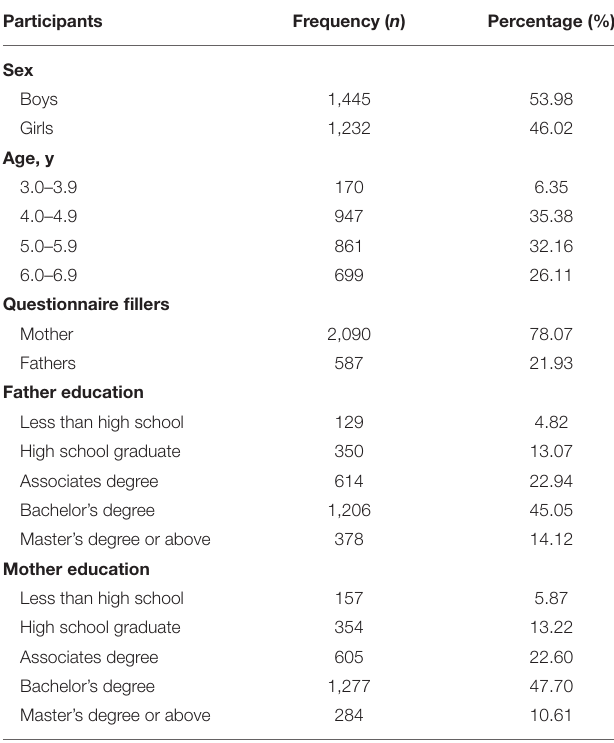
TABLE 1 | Characteristics of participants ( n =